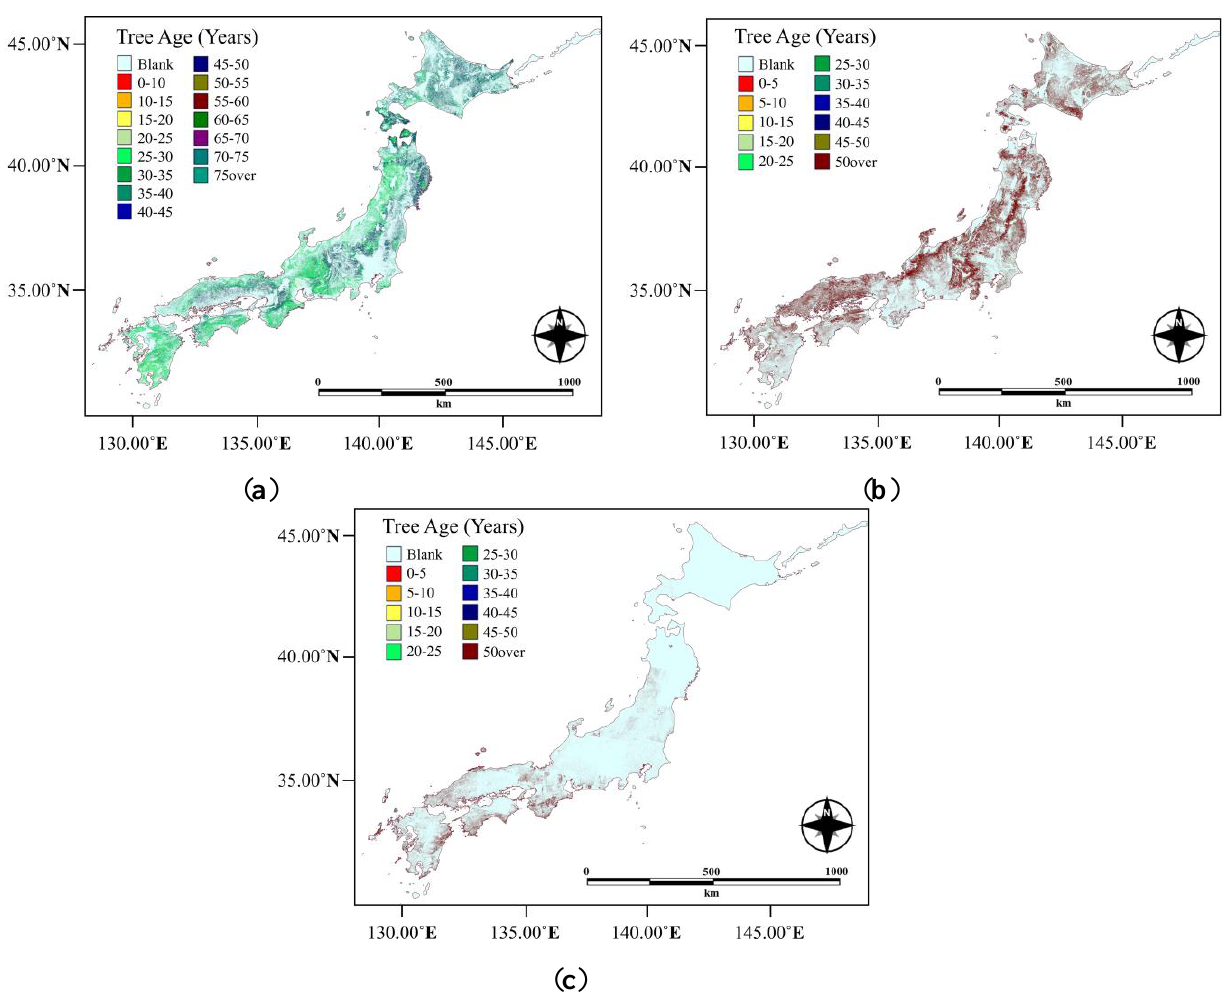
Figure 11. Tree age map transformed from the stem volume map for the ( a ) coniferous, ( b ) deciduous broadleaf and ( c ) evergreen broadleaf